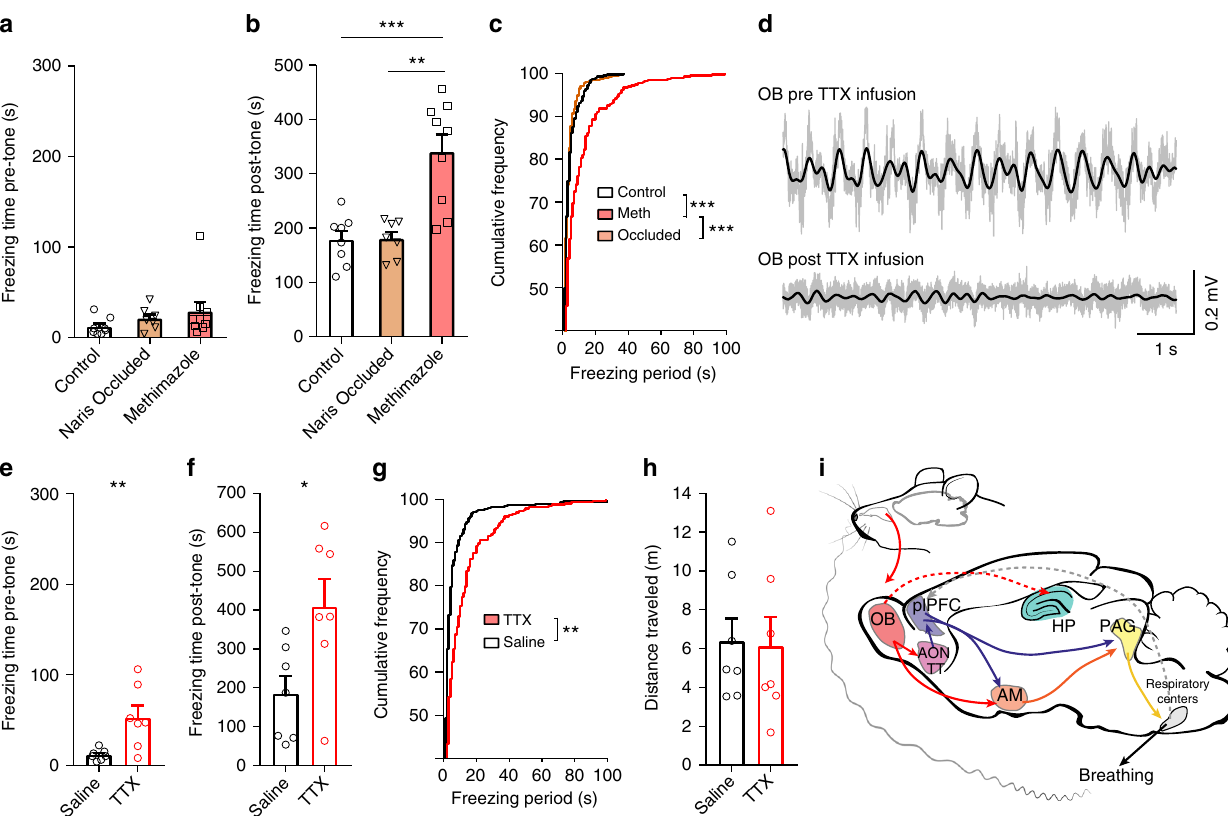
Fig. 6 Disruption of olfactory inputs prolongs freezing periods. a Baseline (pre-tone) freezing time is not signi fi cantly different among control ( n = 8), unilateral naris occlusion ( n = 7) and methimazole treated ( n = 9) groups (one-way ANOVA F (2,21) = 1.281, p = 0.299). b Freezing time during the retrieval trial is signi fi cantly longer in methimaole treated mice compared to control and naris-occluded animals (one-way ANOVA F (2,21) = 15.61, Tukey post hoc, control vs methimazole p < 0.001, naris occluded vs methimazole p < 0.001). c Cumulative frequency distributions show methimazole treated animals have an increased frequency of longer freezing periods compared to control or naris-occluded mice ( p < 0.001, two-sample Kolmogorov – Smirnov test). d Example traces of OB LFPs, 2 – 6 Hz fi ltered traces are overlaid on raw traces (gray) before (pre TTX) and 30 min after intrabulbar injection of TTX (post TTX). e Baseline (pre-tone) freezing time is signi fi cantly longer in TTX infused mice (53.71 ± 13.13 s, n = 7) compared to saline infused mice ( n =